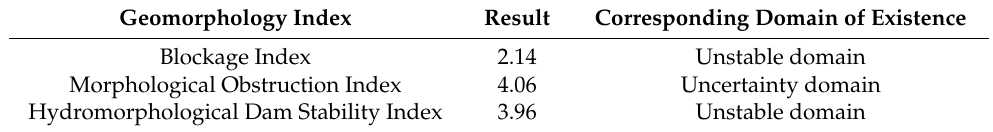
Table 4. Geomorphological indices